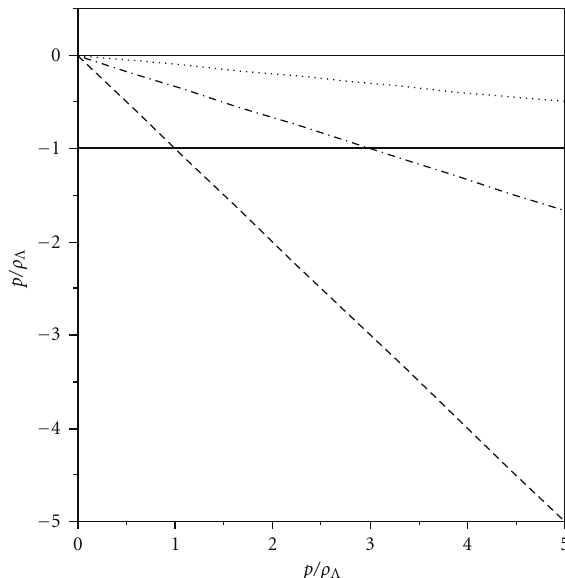
Figure 1: The UDM p − ρ plane with the most important areas, (see [44]). The dashed line represents the p = − ρ line; the dash- dotted line represents the p = − ρ/ 3 line, the boundary between the decelerated expansion phase of the Universe and the accelerated one; the dotted line p = − ρ/ 10 represents a fictitious boundary, above which the CDM-like behaviour of the UDM fluid dominates. The pressure and the energy density are normalised to ρ Λ (where ρ Λ = Λ ). The Λ CDM model is represented here by the solid horizontal line p/ρ Λ = − 1, while the line p = 0 represents an EdS model, that is, pure